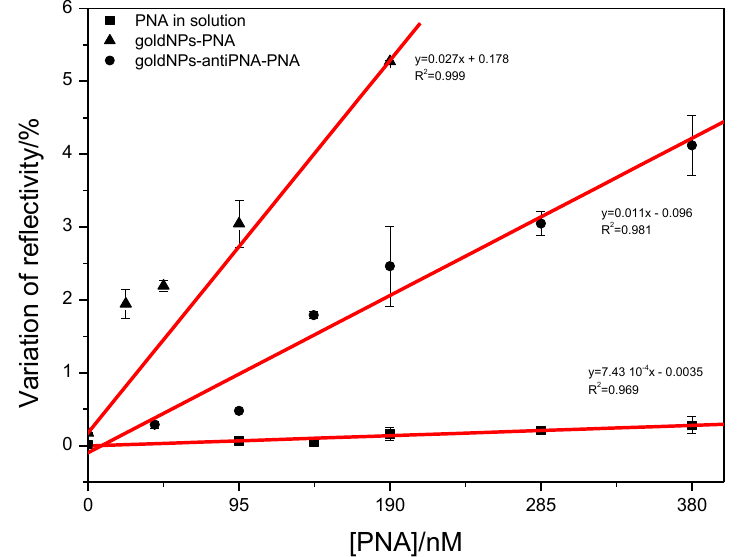
Figure 6. Average values and standard deviation of the variation of reflectivity as a function of the concentration of PNA detected by SPR. Linear fitting was applied for each method (red line). The linear equation and the correlation coefficient calculated for each method are displayed beside the correspondent